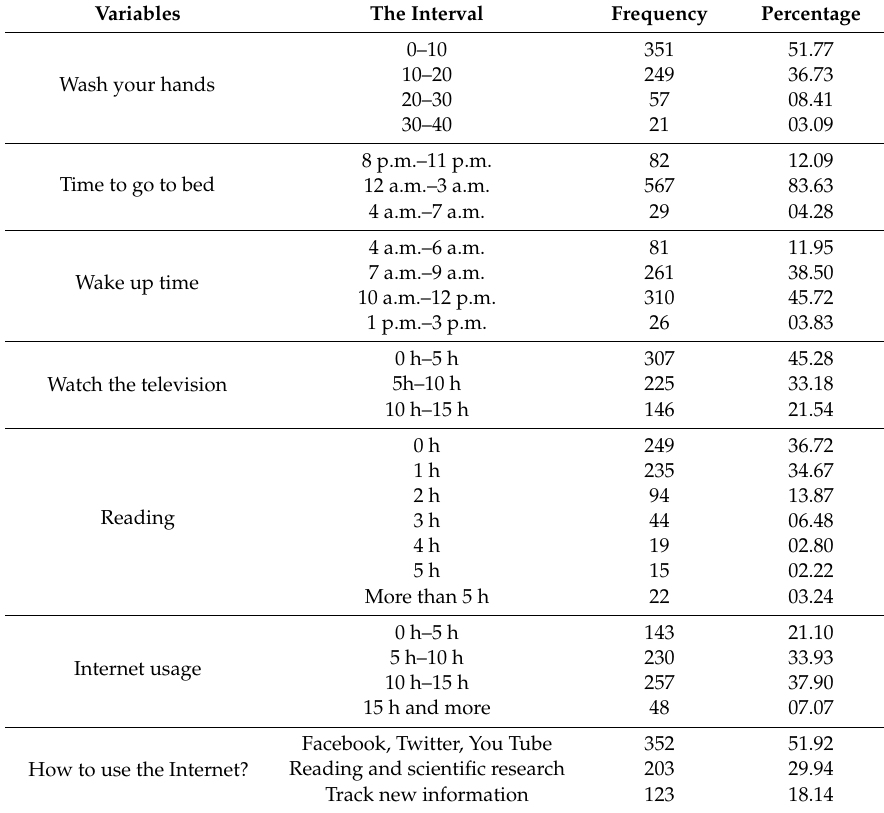
Table 3. Descriptive statistics of the variables for daily living habits during the first confinement of the coronavirus pandemic COVID-19 in